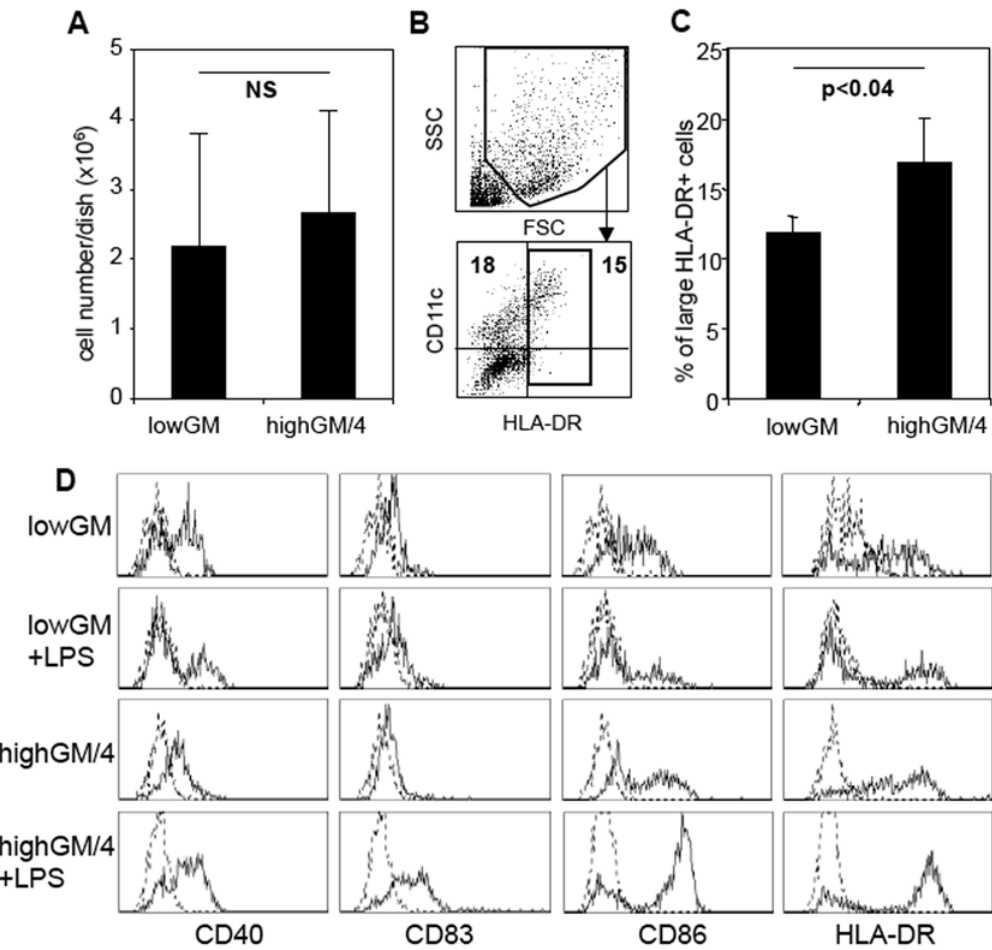
Figure 1. Human BM-derived lowGM-DC do not upregulate surface markers upon maturation. Human BM cells were cultured under standard conditions with 800 U/ml GM-CSF plus 250 U/ml IL-4 or under lowGM conditions with 5 U/ml GM-CSF for 6 days in RPMI + 1% AB plasma. A. The cells were harvested and counted under trypan blue exclusion. The mean values 6 standard deviations of 8 independent experiments are shown. B. The harvested cells were analysed by flow cytometry by setting gates on large cells in the FSC/SSC profile and HLA-DR + cells. C. Analysis of 3 independent experiments as gated in B. Mean values 6 standard deviations are shown. D. The cells were then exposed to 100 m g/ml LPS for 24 h to induce maturation or left untreated and surface stained for the indicated markers (straight lines) or isotype controls (dotted lines). Cells were gated as in B to exclude lymphocytes and precursor cells. The data from one experiment shown are representative of 5 independent experiments.